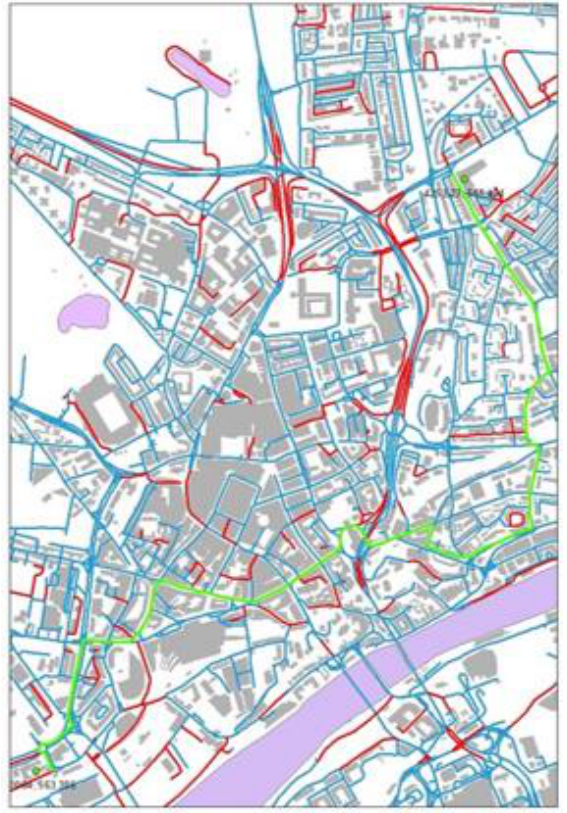
Figure 5. Result of applying a generalised least cost analysis